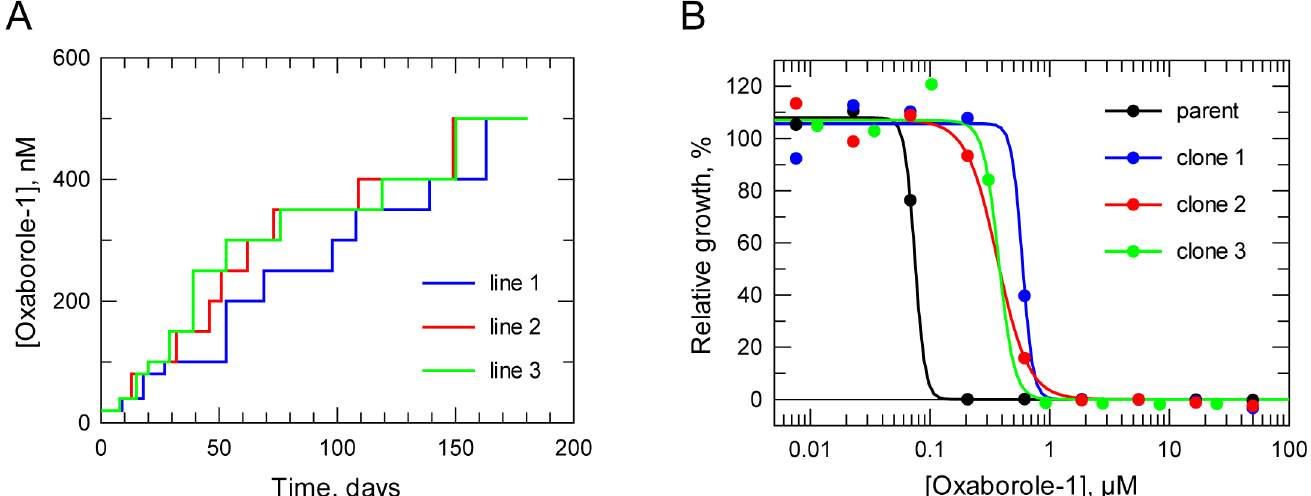
Fig 4. Generation of cell lines resistant to Oxaborole-1. A. Stepwise generation of resistance to oxaborole. B. Representative drug sensitivity plots. The parental cloned line had an EC 50 value of 64.4 ± 1.8 nM and the resistant clones 1, 2 and 3 had EC 50 values of 530 ± 21, 390 ± 17 and 340 ± 27, nM, respectively. Data are the weighted mean of three independent